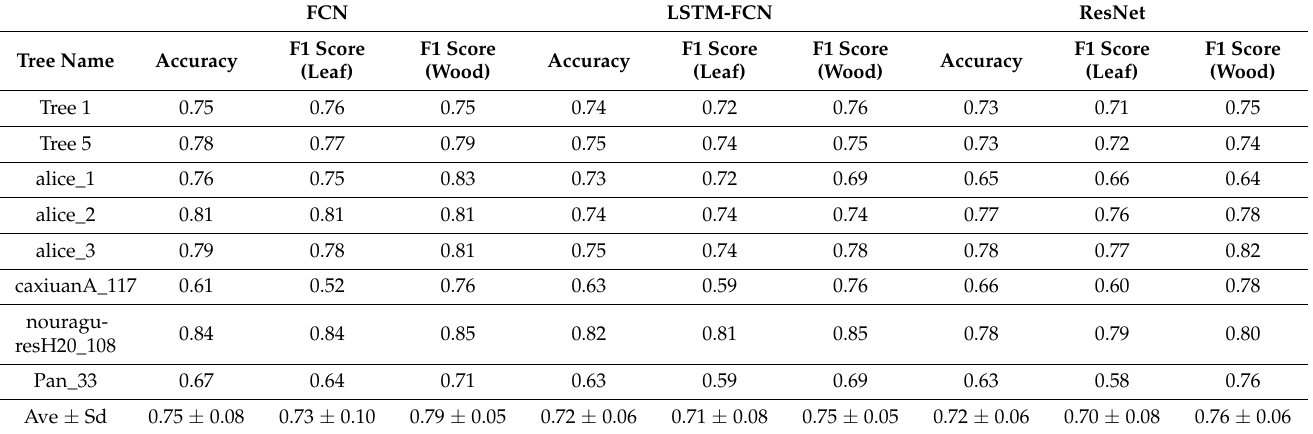
Table 4. The performance of multivariable time series (MTS) of FCN, LSTM-FCN, and ResNet on independent data; accuracy means the corrected classified leaf and wood points against the total points (Ave, average; Sd, standard